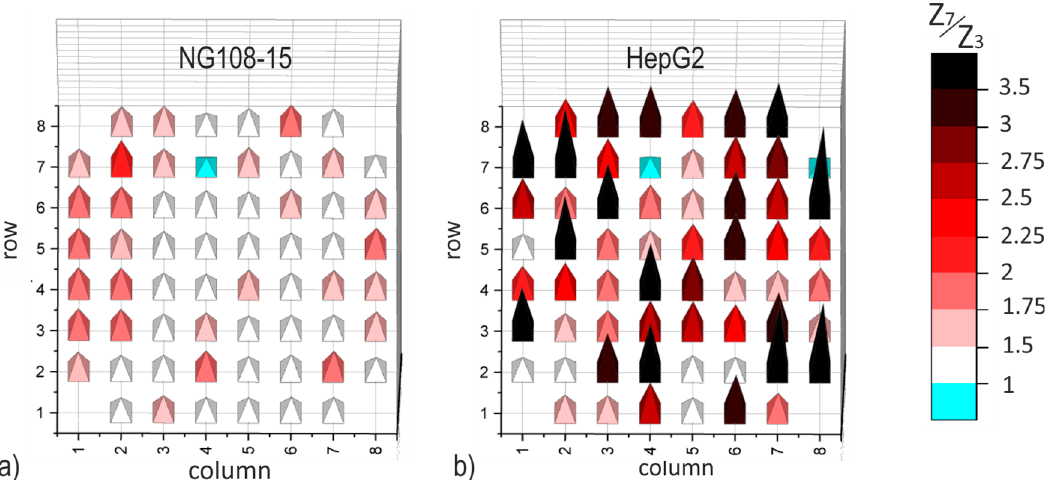
Figure 8. Spatial mapping of the impedance ratio Z 7 /Z 3 (PEDOT-MEAs) measured on single electrodes at 1 kHz: ( a ) NG108-15 cell culture and ( b ) HepG2 cell culture.